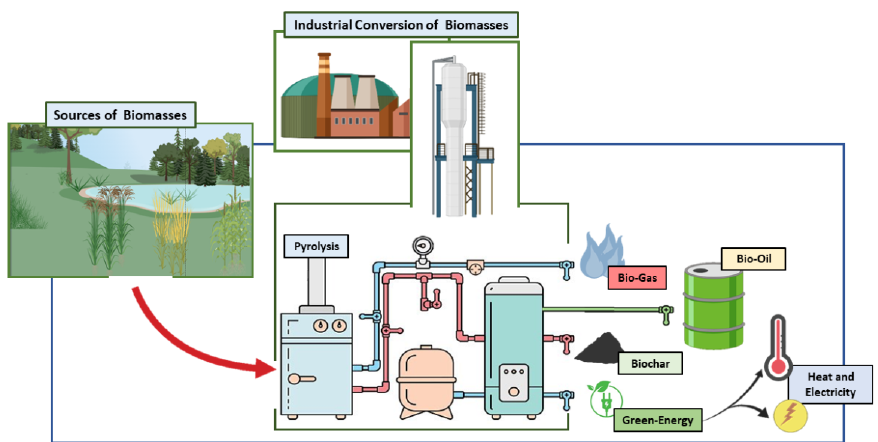
Figure 2. Schematic representation of the industrial conversion of biomasses by pyrolysis.